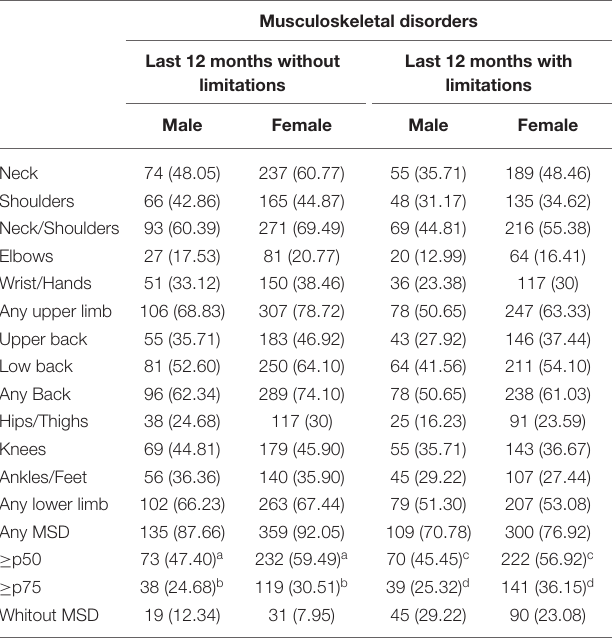
TABLE 4 | Prevalence of musculoskeletal disorders in the last 12 months with and without movement limitations according to